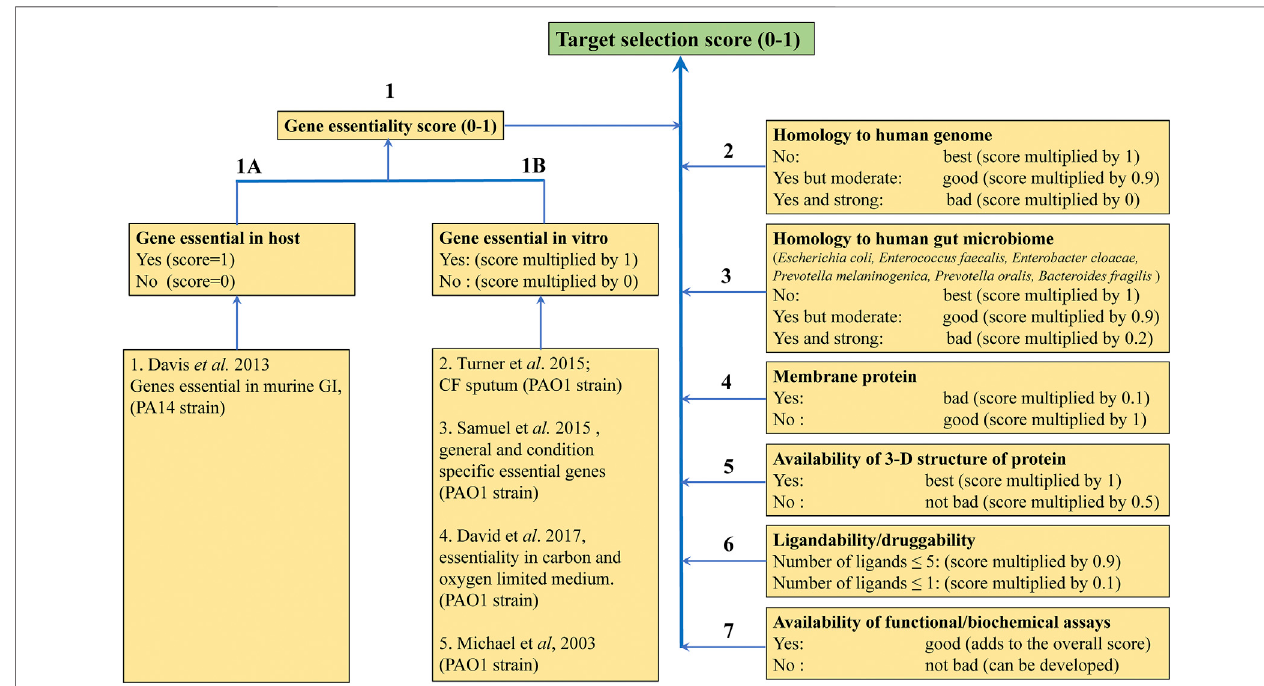
FIGURE7| Criteriaforselectingproteintargetsfrom P.aeruginosa tobestudiedusingFBDD.Differentweightsweregiventothedifferentcriteriaaccordingtotheir impact on target selection.